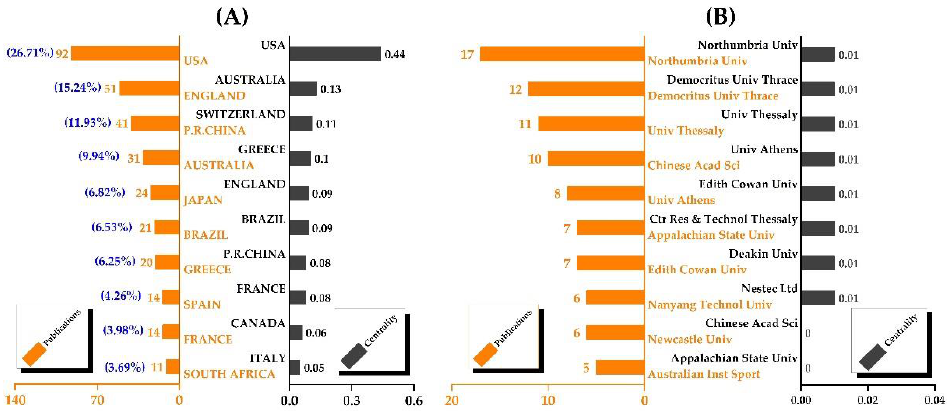
Figure 2. The contributions of countries and institutions. ( A ) The contributions of countries; ( B ) the contributions of institutions.